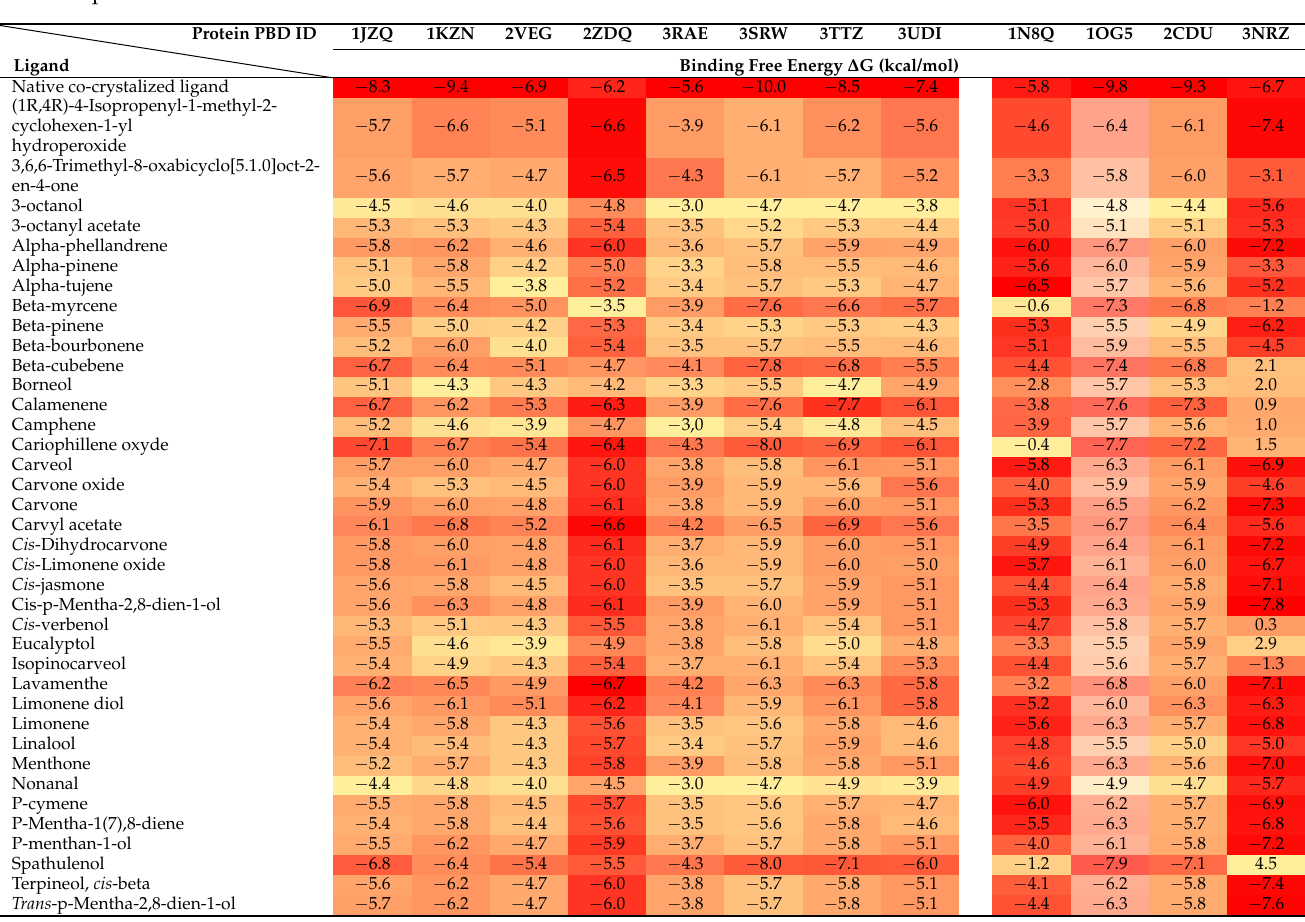
Table 5. Heat map of recorded docking scores (binding free energy—kcal/mol) of the essential oil of M. smithiana components 1